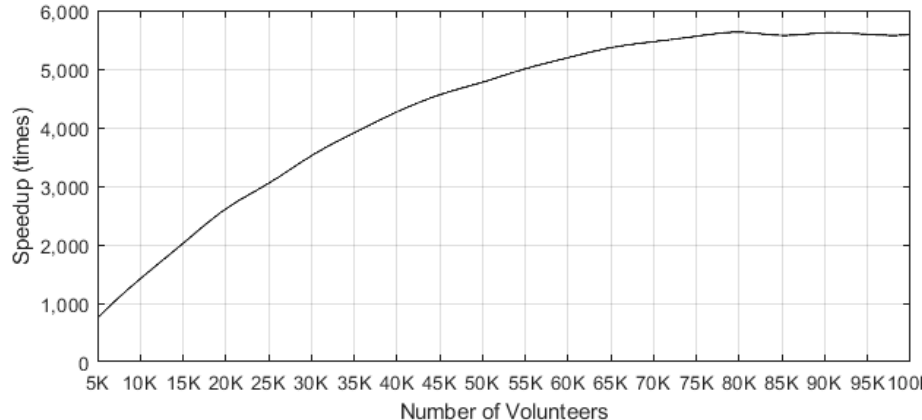
Figure 2. The speedup vs. the size of volunteer